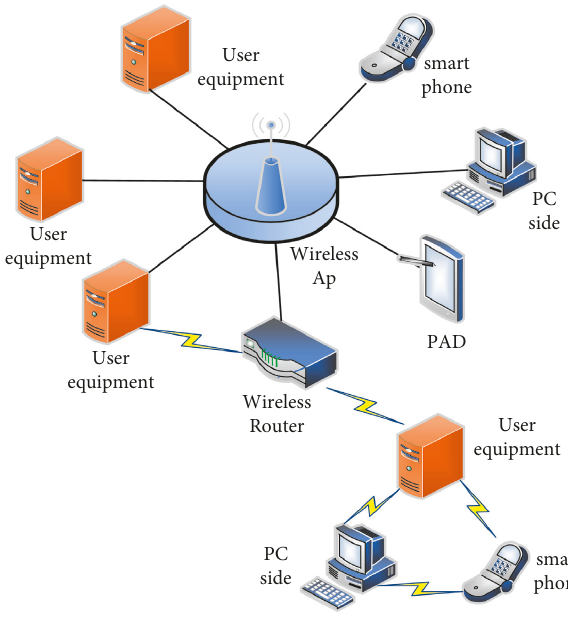
Figure 3: Analysis of WiFi wireless transmission technology.